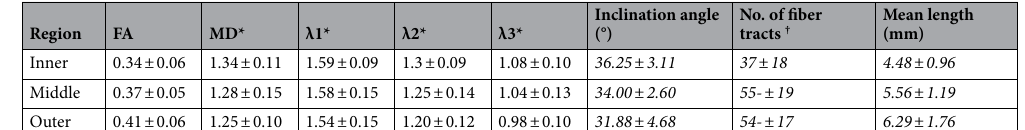
Table 2. Analysis of the mean diffusion parameters along the fiber tracts with standard deviation according to circumferential regions based on their proximity to the center. In italics, absolute values analysis of the mean morphological parameters (n = 8) with standard deviation divided into circumferential regions based on their proximity to the center. *(× 10 –3 mm 2 /s). † × 10 3 .